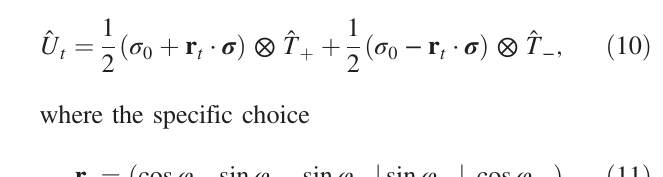
FIG. 1. A 1 D quantum walk with time-dependent spin quan- tization axis ˆ r simulating dynamics of a 2 D systems when the t period of r is incommensurate with the discrete time steps of the t evolution operator. This engineering of synthetic dimensions allows us to sidestep the fermion-doubling principle and to simulate, e.g., the 2 D surface states in isolation of a 3 D quantum spin Hall